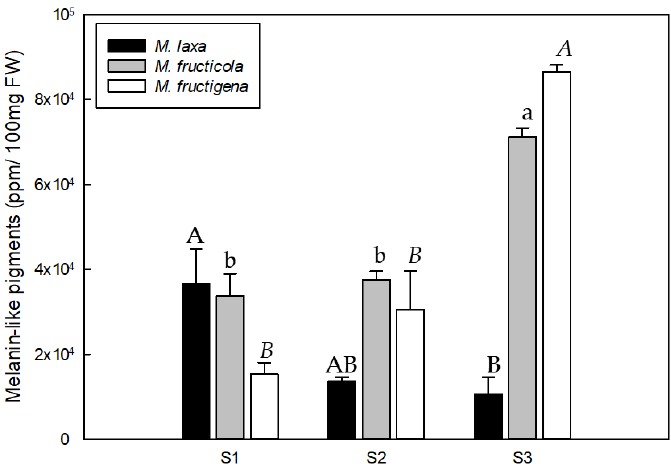
Figure 4. Spectrophotometric quantification (OD 414 ) of Monilinia spp. melanin-like pigments ex- pressed as parts per million (ppm) during the infection process of ‘Red Jim’ nectarines at different stages of the disease development (S1: peel surface maceration stage; S2: colonization stage; and S3: spreading stage) following incubation under darkness. Different uppercase, lowercase, and italic letters indicate significant differences ( p ≤ 0.05) for M. laxa , M. fructicola, and M. fructigena species, respectively, between disease development stages. Error bars represent the standard deviation of the means (n = 3).